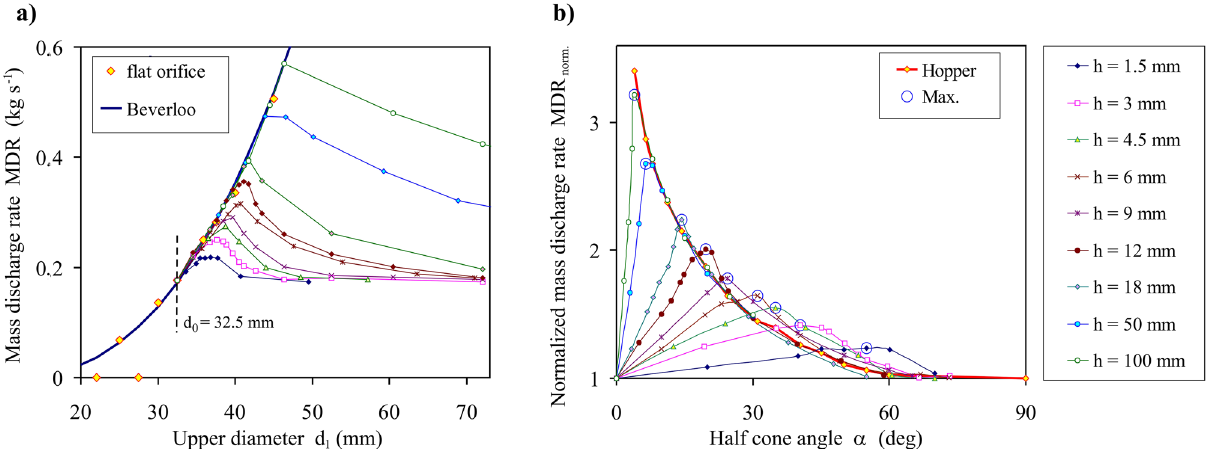
Figure 3. ( a ) Mass discharge rate MDR influenced by the upper diameter of the orifice d 1 for d 0 = 32.5 mm and several values of the orifice thickness h . Discharge through the flat orifice approximated by Beverloo’s equation for C = 0.54 and k = 1.65, and ( b ) simulated MDR norm. normalized by the mass discharge rate through the flat orifice with d 1 = d 0 = 32.5 mm as a function of the half cone angle α